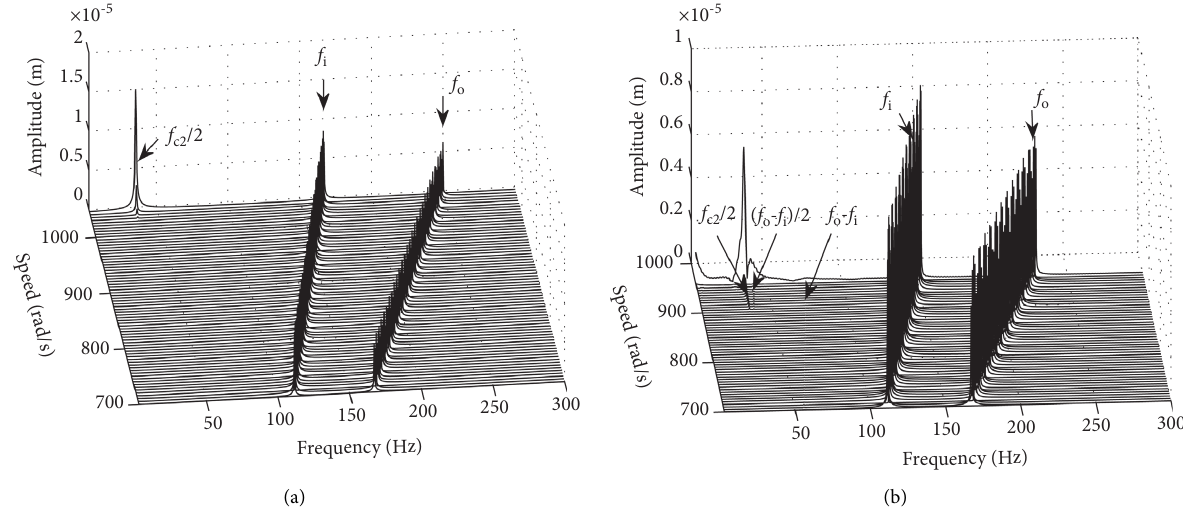
Figure 15: Waterfall plots of the MSDS with K